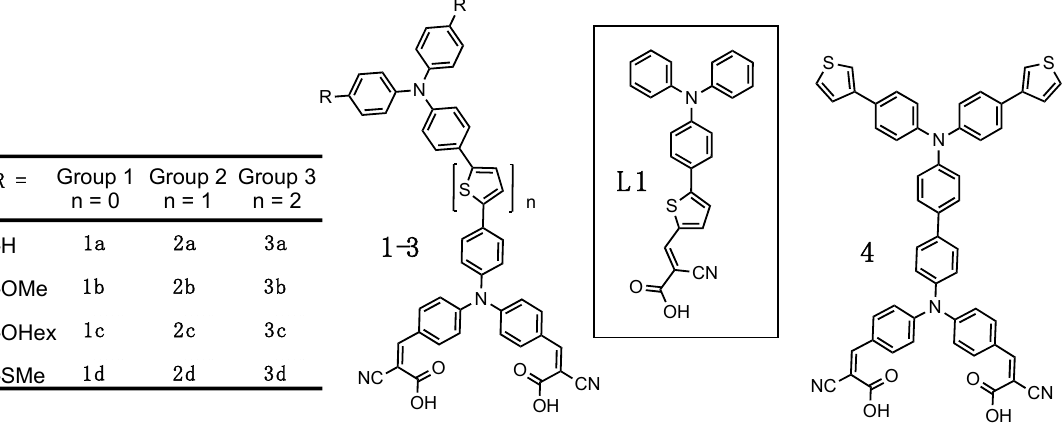
Figure 2. A family of bichromic-bipodal dyes; L1 as benchmark; and 4 a dye with thiophene polymerizable units.